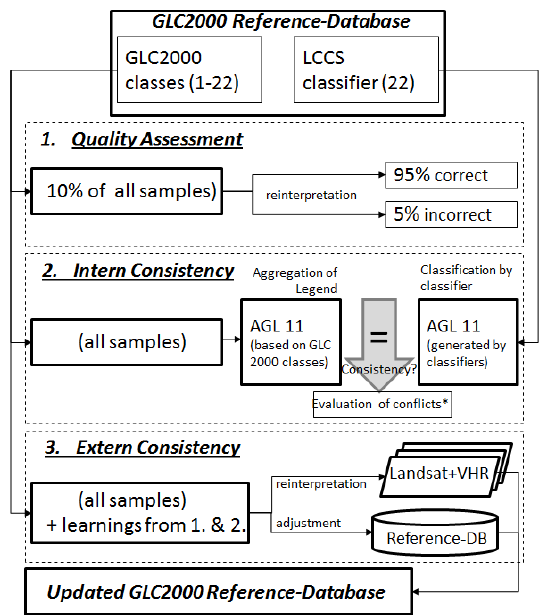
Figure 2. Steps followed for the quality and consistency check of the GLC2000 reference dataset